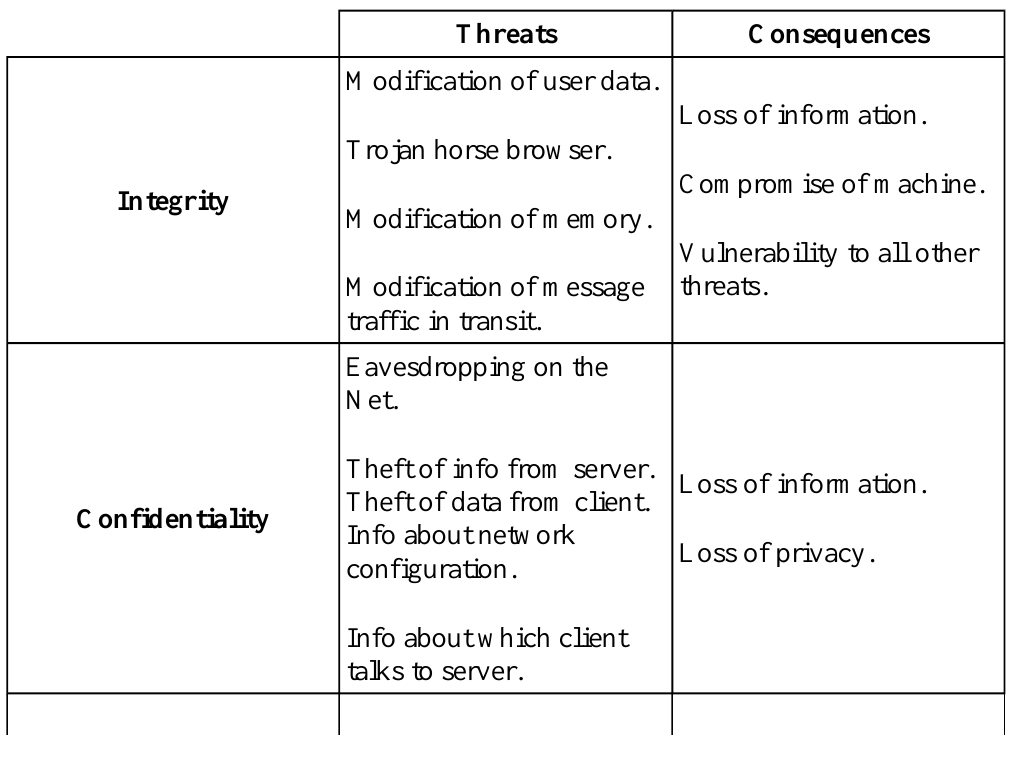
Table 1 Comparing